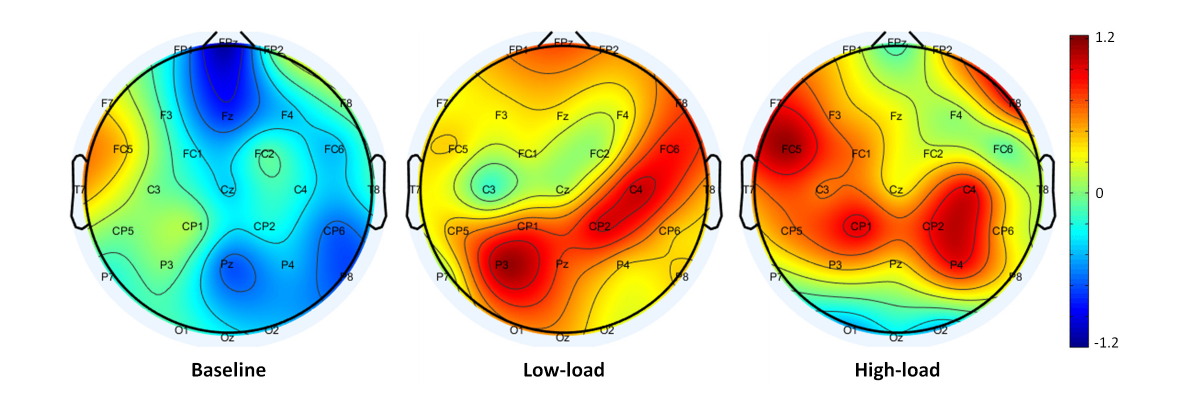
FIGURE7 Brain topographies of alpha power distribution in two conditions compared to baseline. From left to right, the topographies represent the average relative alpha power for the eye-opened baseline, low-load, and high-load